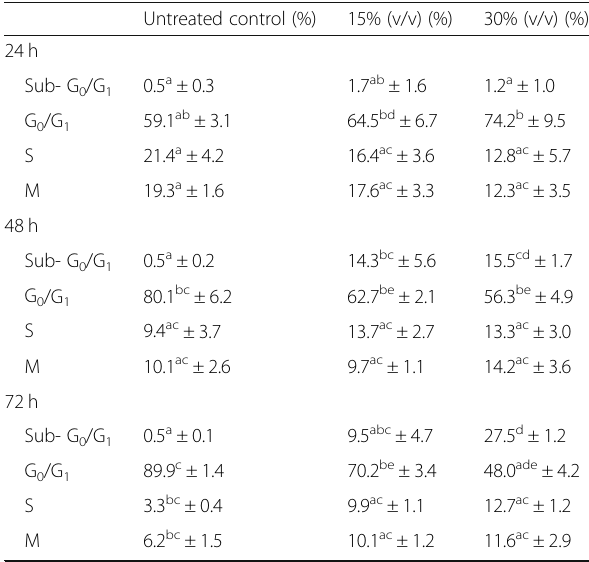
Table 2 Effect of postbiotic UL4 on cell cycle phases distribution of MCF-7 cells